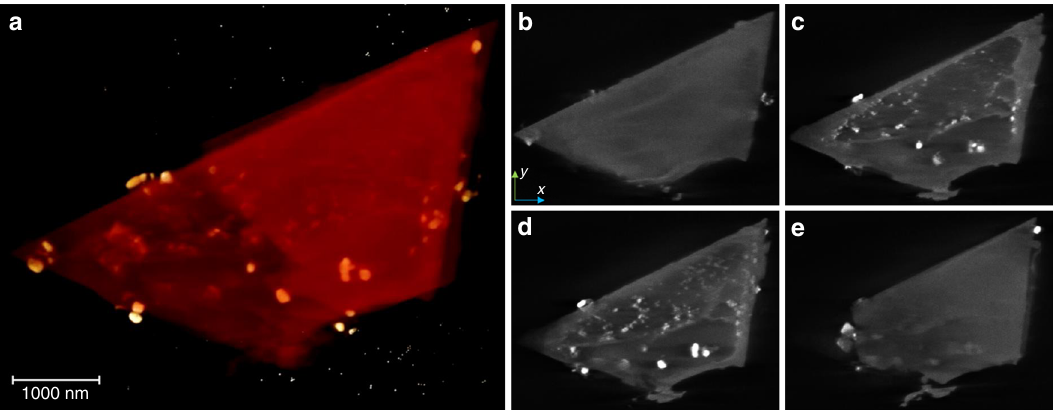
Fig. 3 Electron tomography analysis of Ni@SiXNS-EtOH. a A screenshot image depicting the volume rendering of the 3D reconstruction and b – e images of slices obtained at different z depths of the 3D reconstruction of a particulate of Ni@SiXNS-EtOH. Slices shown in b and e reveal almost no Ni-containing nanoparticles on the top and bottom of the composite particulate, whereas those shown in c , d reveal the presence of Ni-containing nanoparticles in the interlayer spaces between SiXNS. Tiny, scattered white dots in the background of a are the added gold nanoparticles as track markers